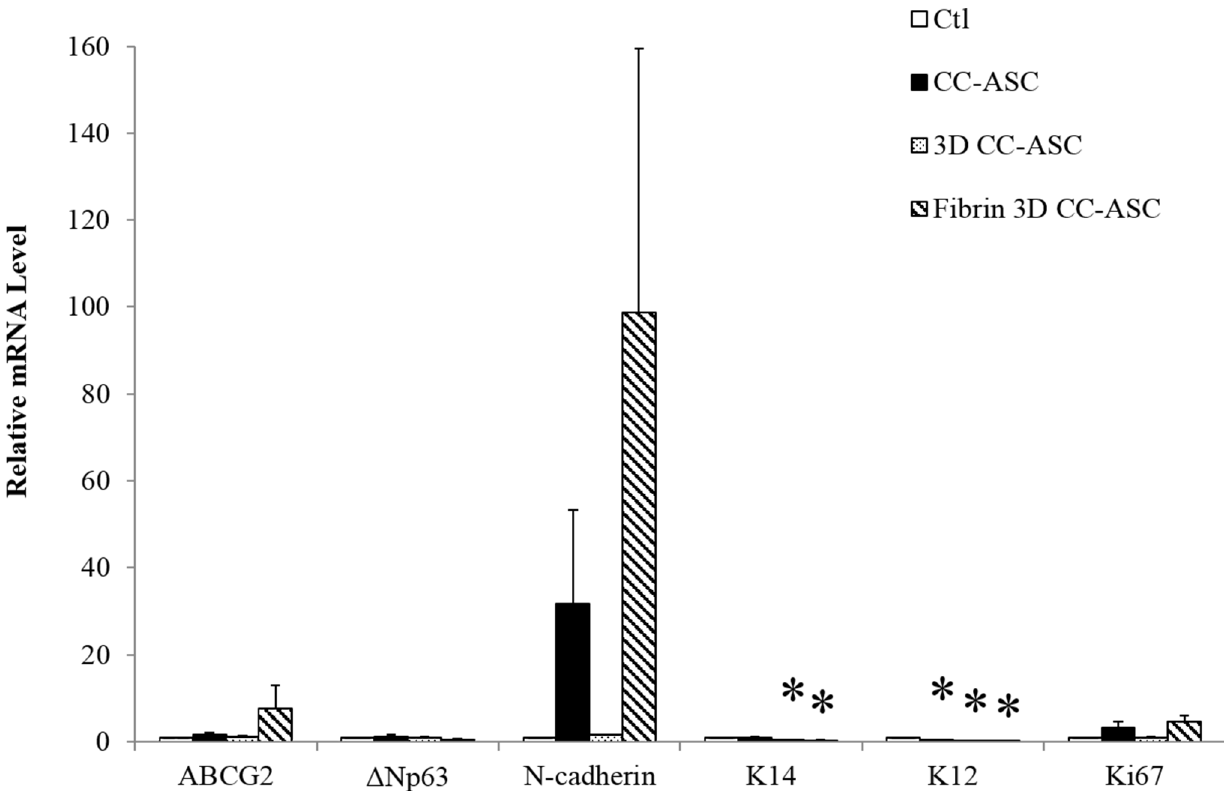
Fig 5. Relative mRNA levels of the putative stem cell markersand maturation markerin cultured LEC cell clusters with ASCs as evaluated by qRT-PCR. The expressionof each marker was normalized to the expressionof housekeeping geneGAPDH and the value of the control group was designated 1. * : p < 0.05in comparisonwith results of the control group. Ctl: control. CC-ASC: cell clusters of LECs cultured directly on ASCs. 3D CC-ASC: cell clusters of LECs culturedon ASCs using the 3D method. Fibrin 3D CC-ASC: cell clusters of LECs cultured on ASCs using the fibrin 3D